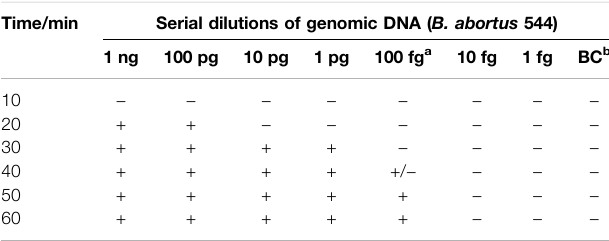
TABLE 3 | The optimization of ampli fi cation time for the B. abortus -LAMP- LFIA assay. Time/min Serial dilutions of genomic DNA ( B. abortus 544) 1 ng 100 pg 10 pg 1 pg